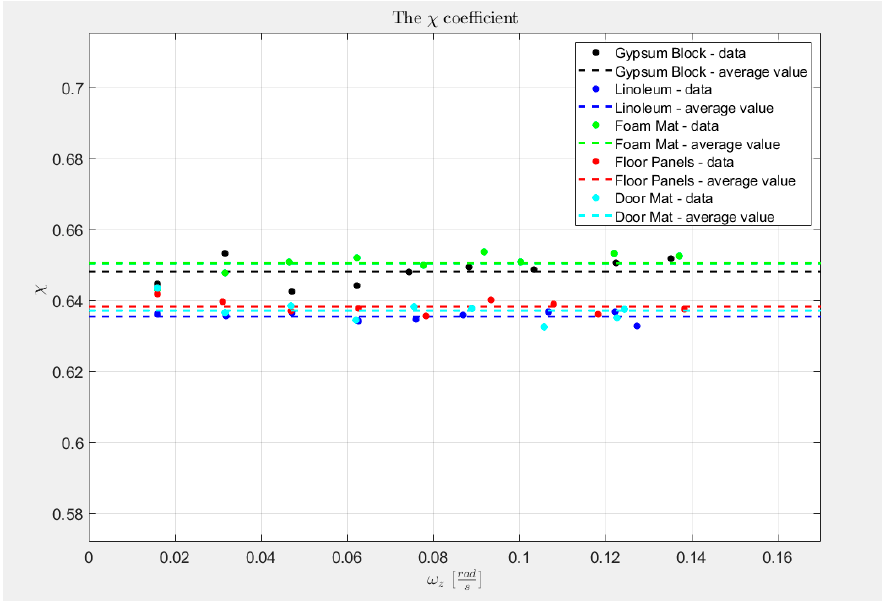
Figure 10. The steering efficiency coefficient 𝜒 as a function of the robot’s angular velocity. Table 6. The calculated steering efficiency coefficient 𝜒 for different robot and surface types.